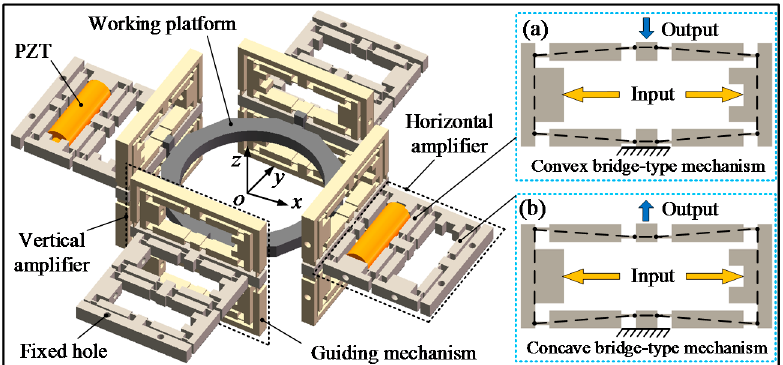
Figure 1. Schematic diagram of the piezoelectric ‐ actuated compliant platform.